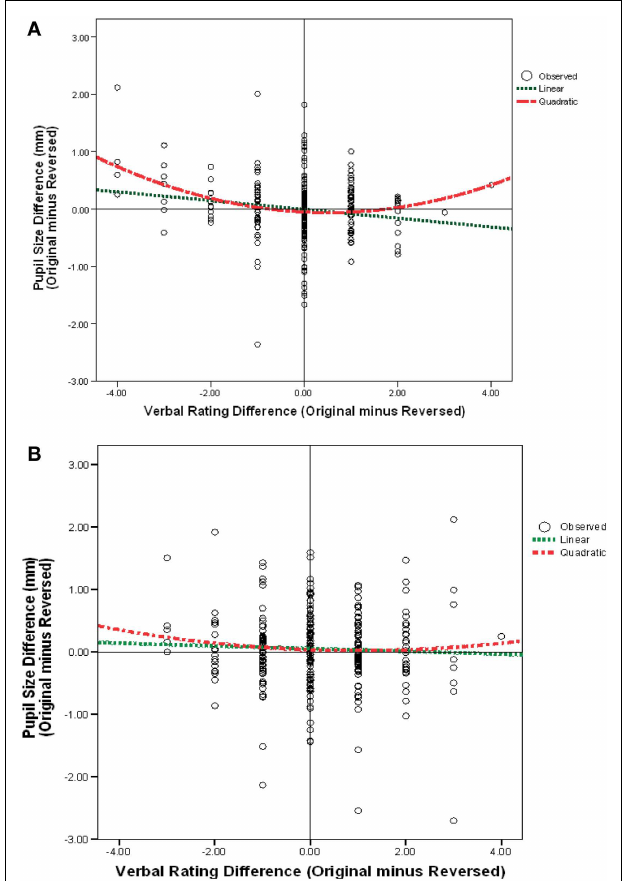
FIGURE 6 | Pupil size difference score (original-minus mirror-reversed) as a function of the difference in 1–9 verbal rating scores (between an original-minus mirror-reversed image) for all (A) male portraits, (B) female portraits .